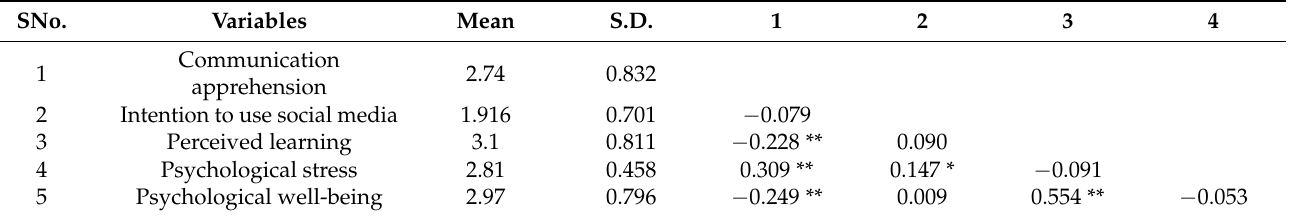
Table 1. Means, standard deviations, and correlations.